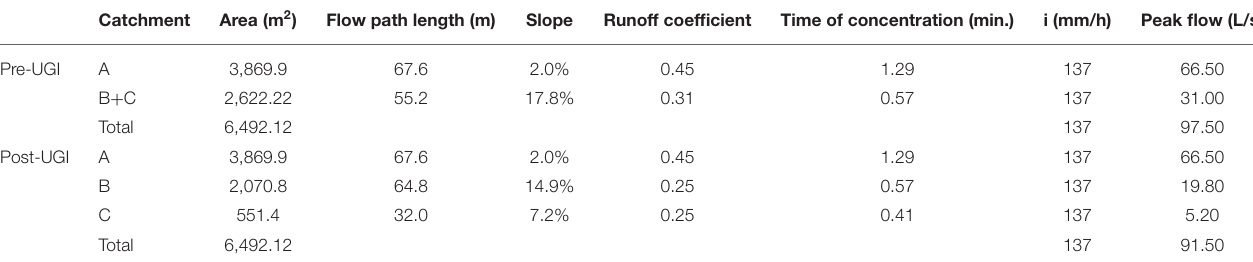
TABLE 4 | Rational method variables and results for pre- and post-UGI implementation for the 10-year return period storm.